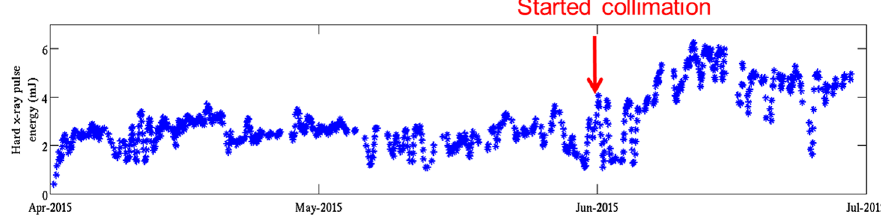
FIG. 6. Archived gas detector history to show the recorded FEL pulse energy before and after using the collimation mode. The photon energy is filtered between 7 to 9 keV. The bunch charge for the period before using the collimation mode was 180 pC from the injector to the undulator, while with the collimation mode, the bunch charge was truncated from 250 pC to 180 pC with BC1 collimator. The actual bunch charge for FEL lasing in this plot is the